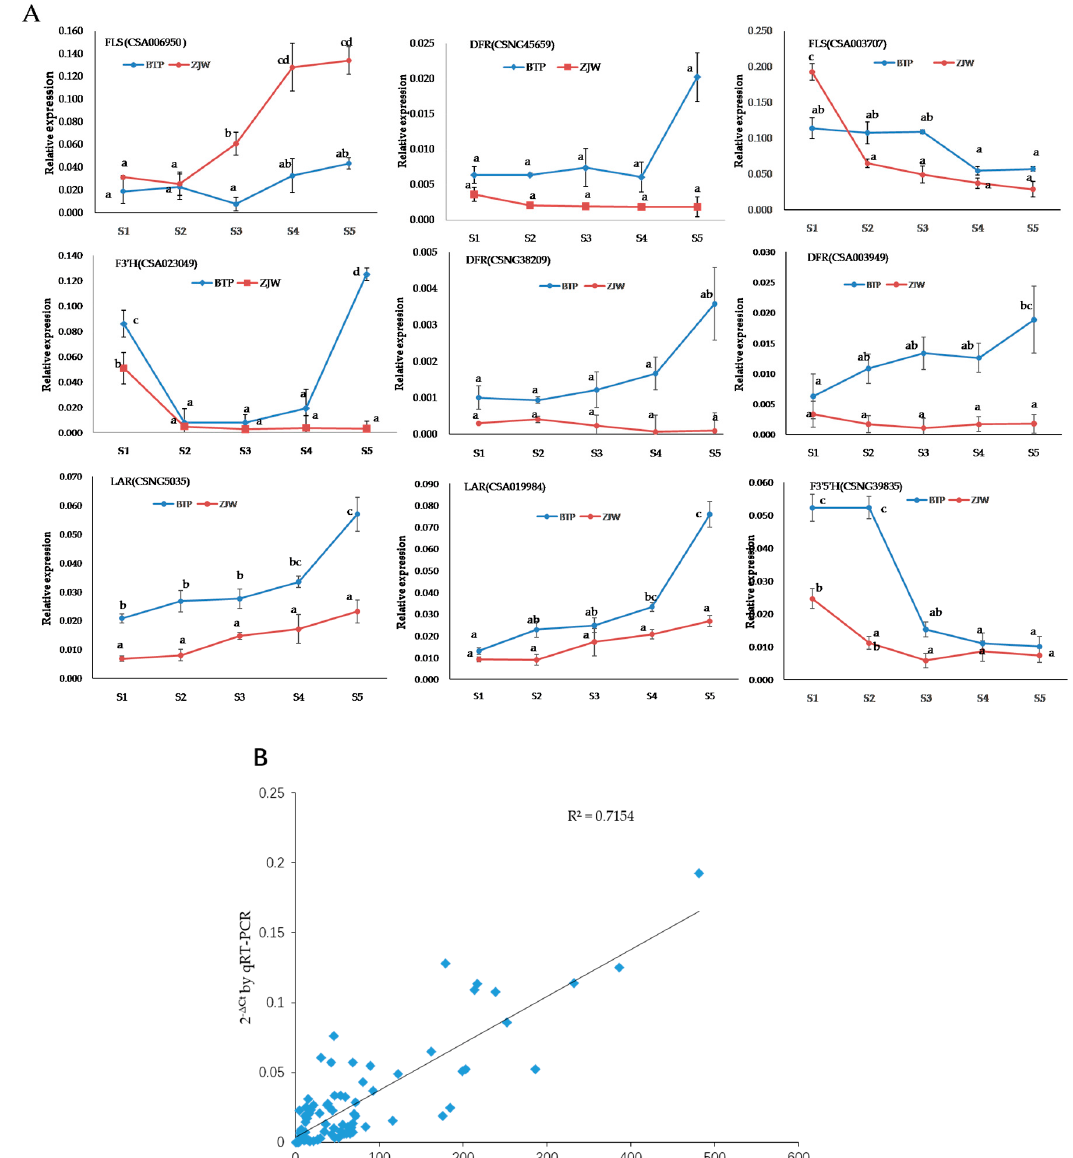
Figure 7. Quantitative real-time PCR (qRT-PCR) validation of 9 structural genes. ( A ) Expression patterns of 9 genes involved in anthocyanin biosynthesis in white and pink tea flower development stage (from S1 to S5). Each column represents an average of three biological replicates, with standard errors indicated by vertical bars. Values with a different accompanying letter are statistically significantly different according to Duncan’s multiple range test at p < 0.05. ( B ) Correlation of the expression levels of 9 selected genes measured by qRT-PCR and RNA-seq. S1, mature flower bud; S2, pre-opening; S3, initial opening; S4, half bloom; S5, full bloom.